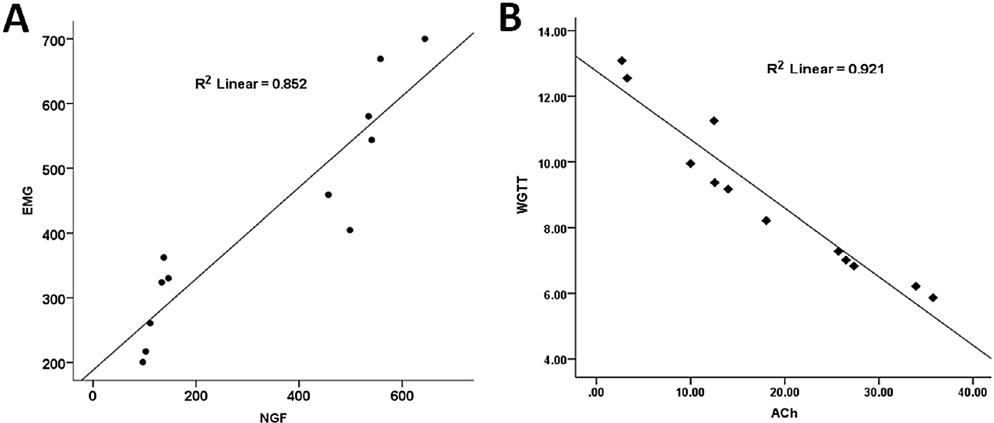
Figure 6. Correlations between plasma nerve growth factor (NGF) and the abdominal electromyogram ( A ) and between plasma acetylcholine (ACh) and the whole gut transit time (WGTT) ( B ) at baseline and one week after the DSS